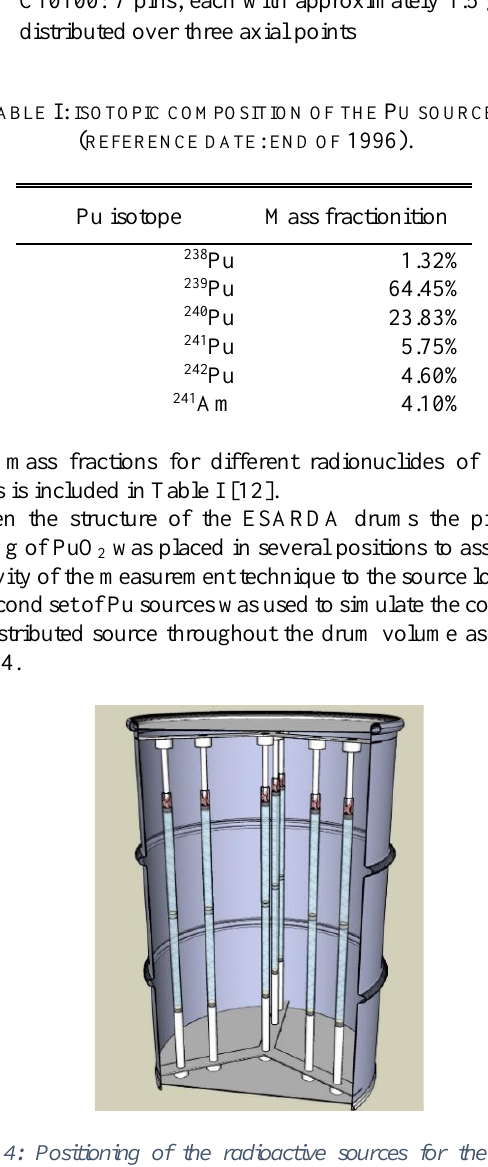
Figure 4: Positioning of the radioactive sources for the 7 pins configuration in a 3D model of a 200 L mock up